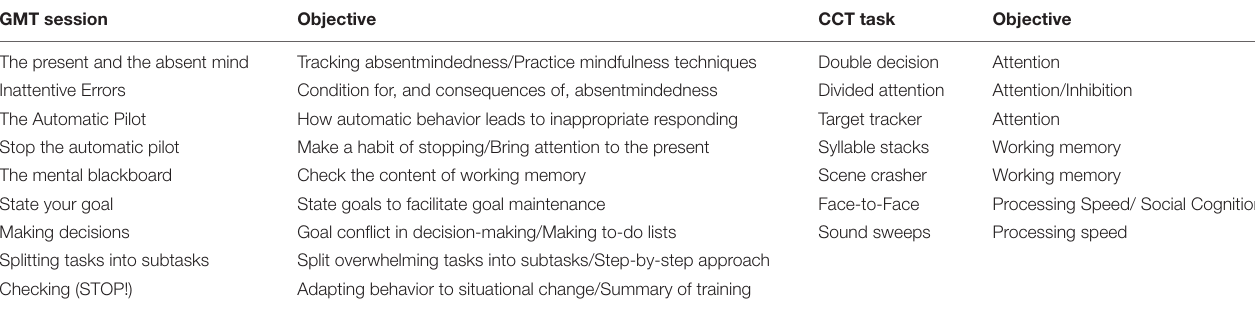
TABLE 1 | GMT sessions, CCT tasks, and objectives. GMT